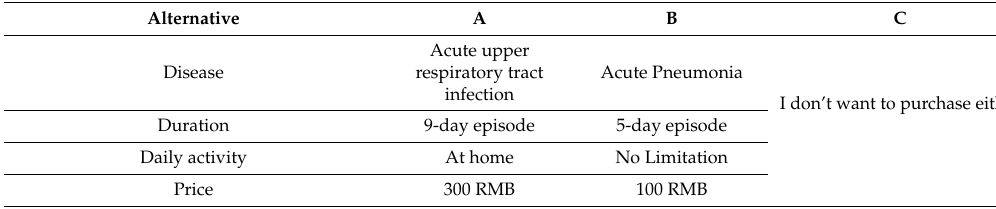
Table A3. Choice set 3.